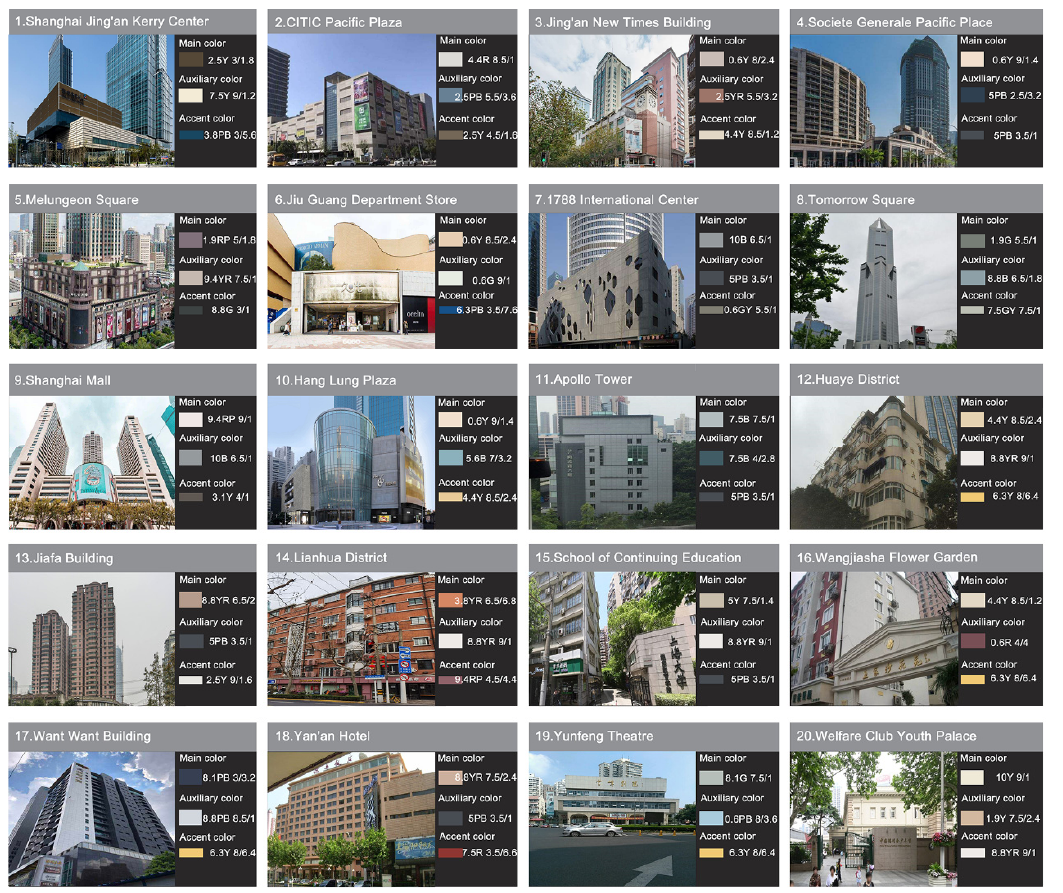
Figure 2. Summary diagram of the study of the color status of typical modern buildings on West Nanjing Road. (Source for the photos of the buildings: https://image.baidu.com (accessed on 11 April 2022).